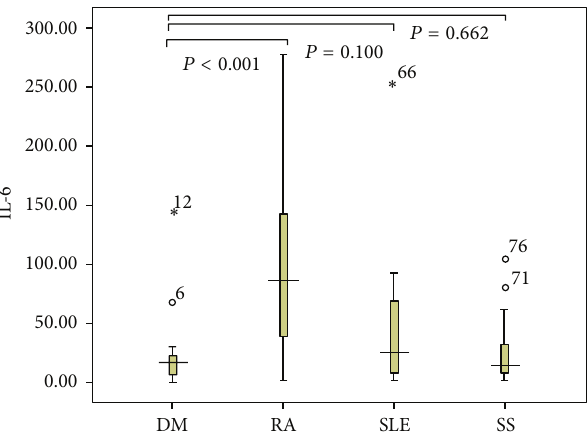
Figure 1: Serum IL-6 levels in patients with DM, RA, SLE, and SS. 1.0